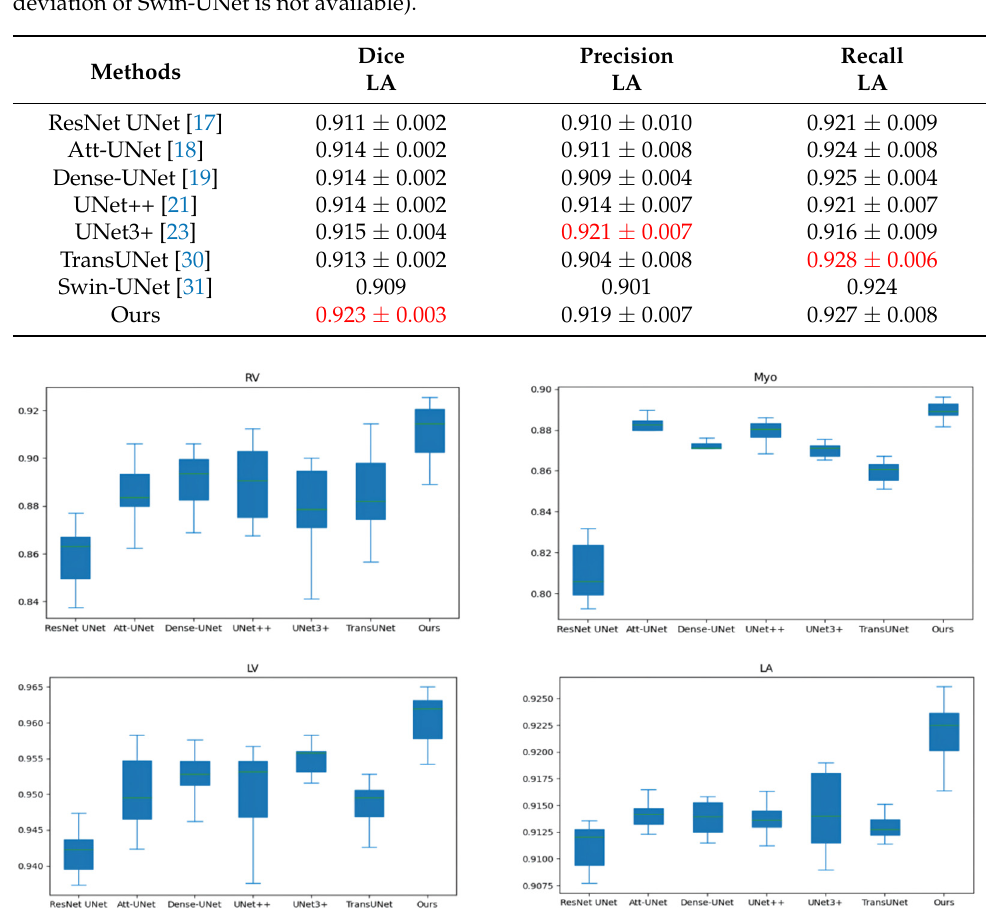
Figure 5. The box and whisker plot on the right ventricle (RV), myocardium (Myo), left ventricle (LV) and left atrium (LA).